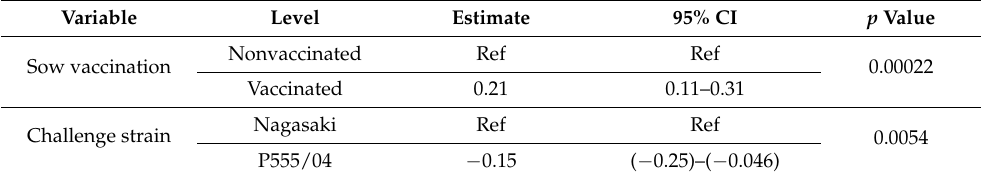
Figure 6. Levels of surfactant protein D (SP-D) in bronchoalveolar lavage fluid (BALF). Piglets born to vaccinated (VAC, pink and orange by biological sow) or nonvaccinated (NVAC, blue and green by biological sow) sows were challenged with G. parasuis at 22 days of life and 2 weeks later were euthanized. At that time, BALF samples were taken and SP-D was measured by a capture ELISA. The individual value for each piglet and the average absorbance in the ELISA (horizontal lines) are shown in the graph. Error bars are the standard deviation. Table 6. The final model with the association of SP-D level BALF in piglets and predictor variables using multivariable linear regression with repeat measurements while accounting for sow identity as random effect.